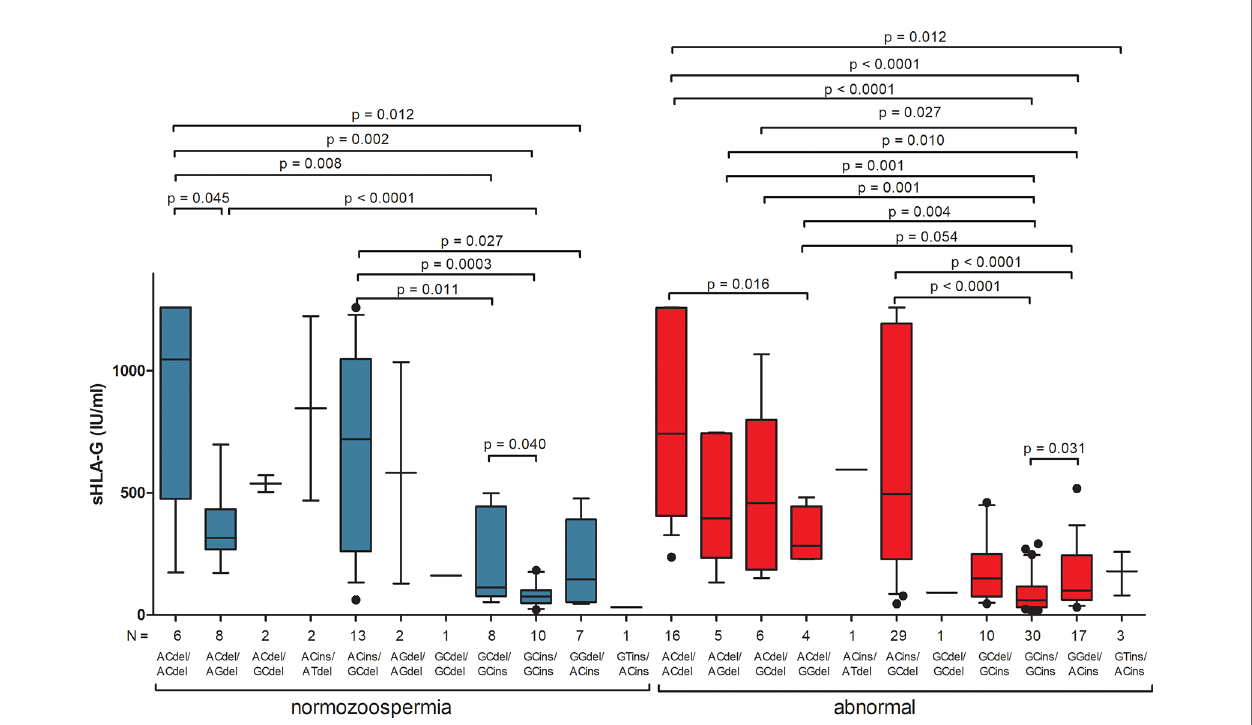
FIGURE 3 | Concentration of soluble HLA-G per milliliter of plasma (IU/mL) measured in semen samples according to HLA-G diplotypes. Diplotypes were estimated in the following order: rs1632947: − 964G>A; rs1233334: − 725G>C/T; rs371194629:insATTTGTTCATGCCT/del. Blue boxes represent the level of sHLA-G measured in normozoospermic men and red boxes – in men with abnormal semen parameters. Boxes are drawn from the fi rst quartile (25th Percentile) to the third quartile (75th Percentile). Black lines in boxes are medians. Whiskers represent 10-90 percentiles. N is the number of patients. P-values are calculated by Mann-Whitney test or unpaired